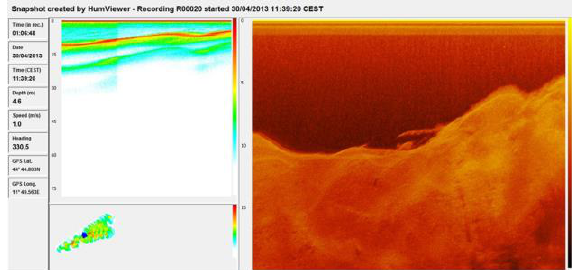
Figure 8. Gambulaga – Portomaggiore (FE), Tramonto Lake, snapshot with big tree trunks.